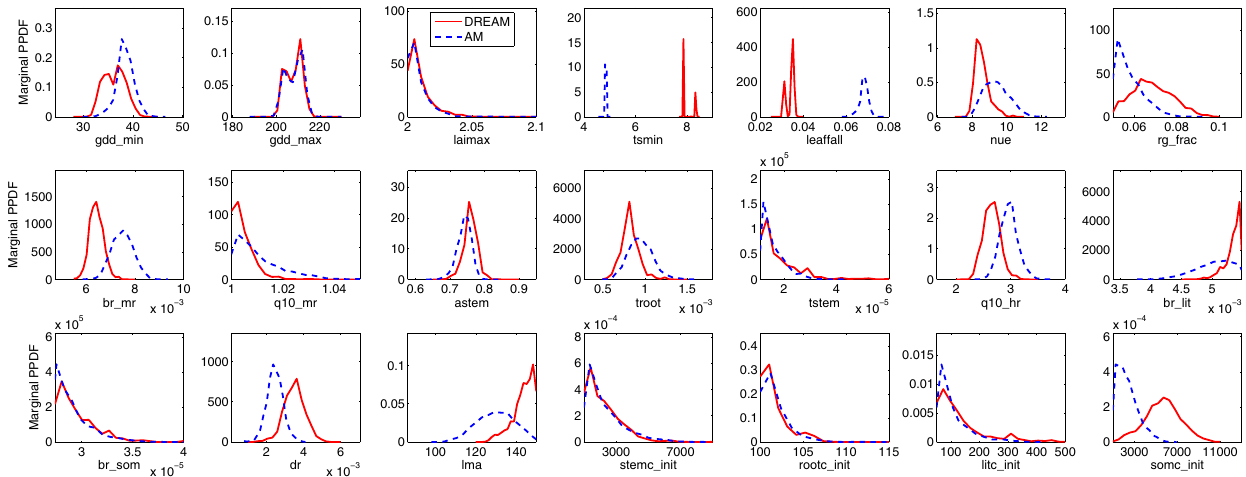
Figure 3. Estimated marginal posterior probability density functions (PPDFs) of the 21 parameters using the AM and DREAM algorithms in the real-data